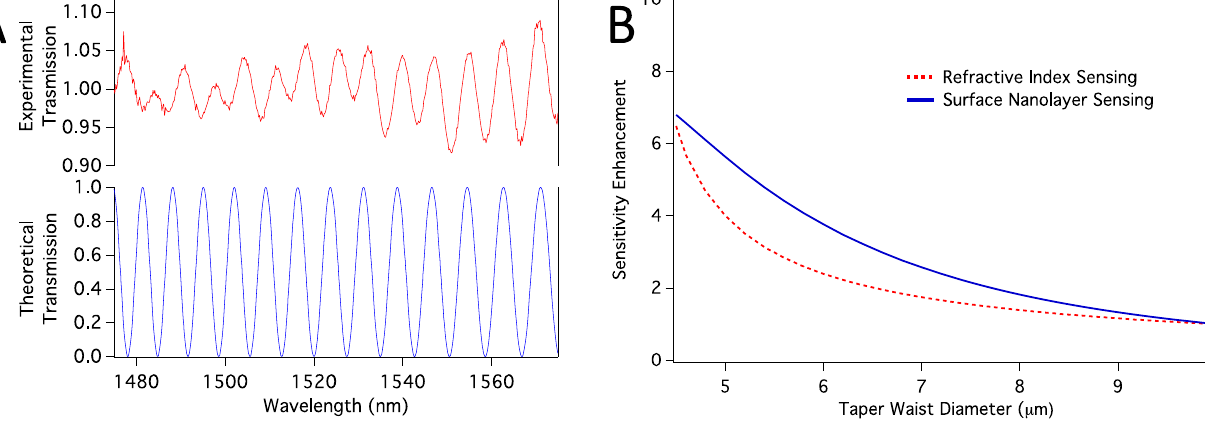
Figure 7. ( a ) Comparison of experimental and theoretical transmission spectra; ( b ) Sensitivity enhancement relative to the sensitivity of a sensor with taper waist diameter of 10